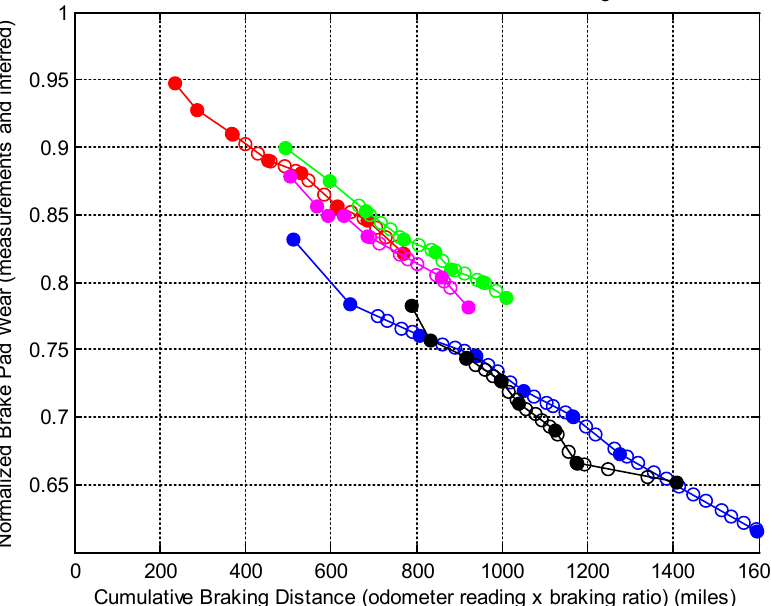
Figure 18. Measured (solid dots) and inferred (unfilled circles) RUL of front driver’s side brake pad thickness against cumulative braking distance as the X -axis.